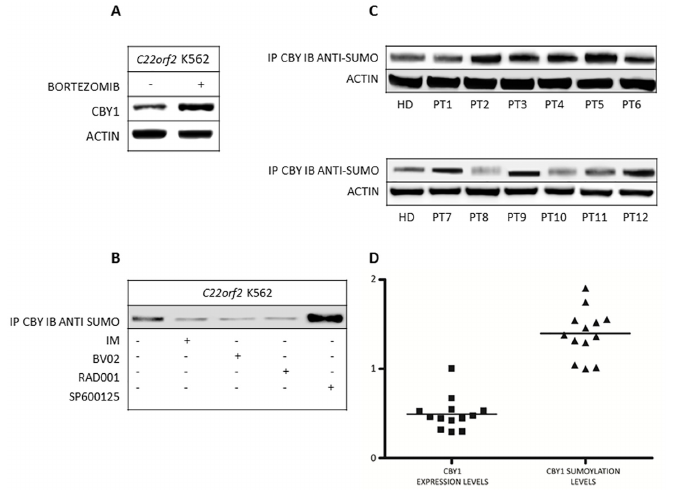
Fig 6. Proteasome degradation through SUMOylation has a role in CBY1 reduced stability associated with BCR-ABL1 TK-mediated binding with 14-3-3 σ . A- Cytoplasmic CBY1 expression was upraised at 24th hour of treatment with Bortezomib (5nM) in C22orf2 K562 cells; B- Reduction of CBY1 SUMOylation was associated with CBY1 upraised expression in response to compounds (IM, BV02 and RAD001) which impair the interaction with 14-3-3 σ . Conversely, CBY1 SUMOylation was increased in response to the JNK inhibitor, which precludes CBY1 release from 14-3-3 σ and reduces CBY1 cytoplasmic levels; C- Higher CBY1 SUMOylation was seen in MCF from bone marrow samples of 12 CML patients at diagnosis compared to pooled HD. Clinical details of CML patients included in our study are illustrated in the S1 Table. The two blots shown here have been run separately and confirmed by two additional independent experiments. D- CBY1 SUMOylation in MCF from CML patients was inversely correlated with the expression of CBY1. Signal intensities of WB obtained with equal amounts of protein from CML and HD samples. CBY1 expression exhibited a decrease of more than 50% with respect to the normal control, while SUMOylation showed an almost 1,5-fold increment compared to the normal control (signal intensity of HD protein pool was set to 1 to represent the reference value). See legend to Fig 1 for technical